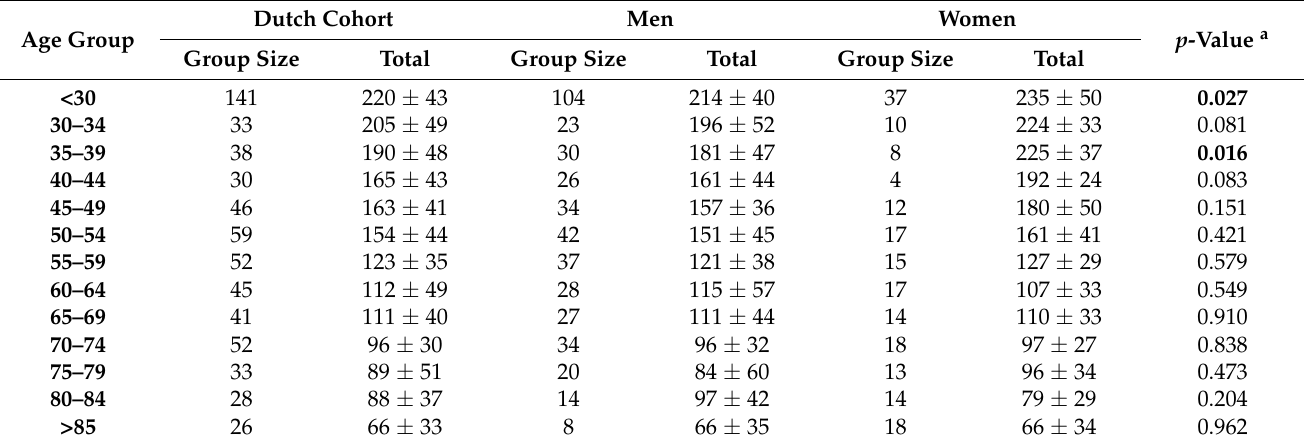
Table 2. Bone mineral density (mean HU ± SD) divided by sex in the Dutch